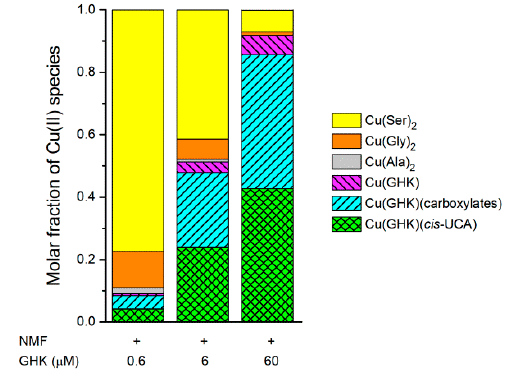
Figure 7. Species distribution simulated for natural moisturizing factor (NMF), 0.9 µM Cu 2+ ions, and different concentrations of GHK, at pH 7.4 (representing the possible conditions in wounds). The lowest concentration of GHK (0.6 µM) is equal to the concentrations found in human plasma. Higher concentrations (6 and 60 µM) of GHK may occur in wounds and/or after application of cosmetics or other products with GHK as the active substance. The protonation constants and stability constants for Cu(II) complexes were taken from the literature [47,48] and this paper. The conditional constant for the ternary complexes formation of Cu(GHK) with carboxylates (68 M − 1 ) [20] was also included in calculations. Concentrations taken for calculations are 43 mM serine, 30 mM glycine, 23 mM pyroglutamic acid, 18 mM alanine, 14 mM lactic acid, and 14 mM cis -UCA [11,12]. All ternary complexes of Cu(GHK) with aforementioned compounds with carboxylic groups were combined in the “Cu(GHK)(carboxylates)”. Only the species exceeding 1% of all Cu(II) species are shown for clarity.